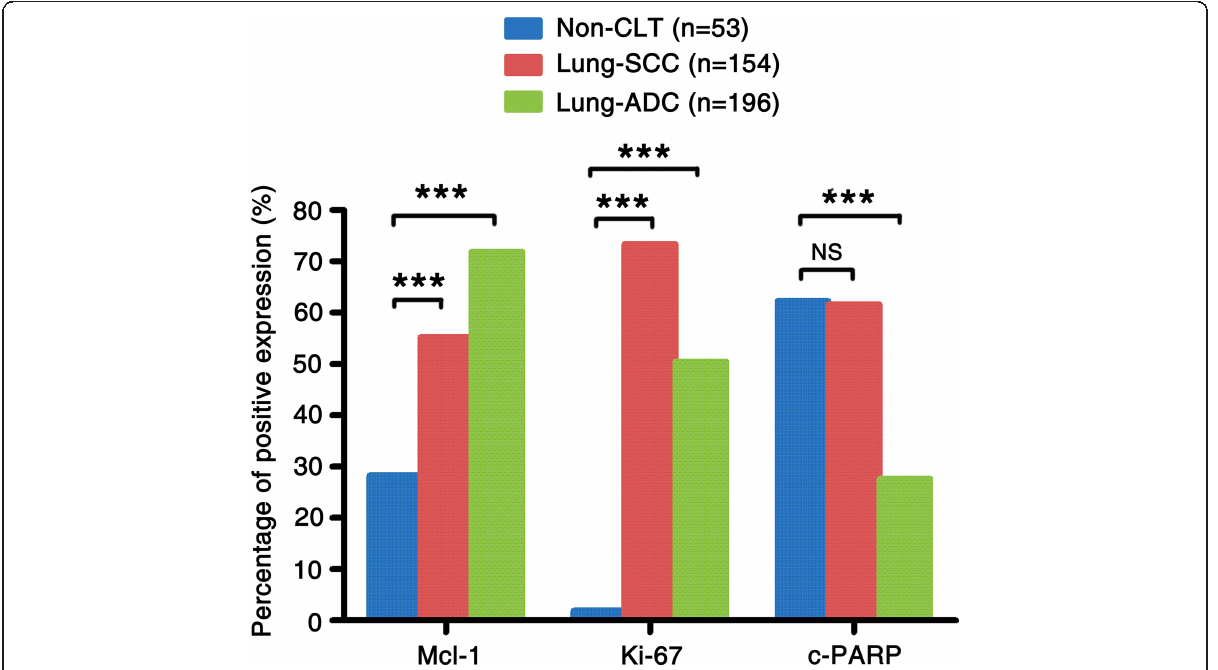
Fig. 3 Mcl-1 expression, Ki-67 PI and c-PARP AI in lung SCC and lung ADC compared to non-CLT. Results showed that there were significant differences between the groups which were statistically by chi-square test (*** P < 0.001). No apparent difference in AI was found between lung SCC and non-CLT ( P >